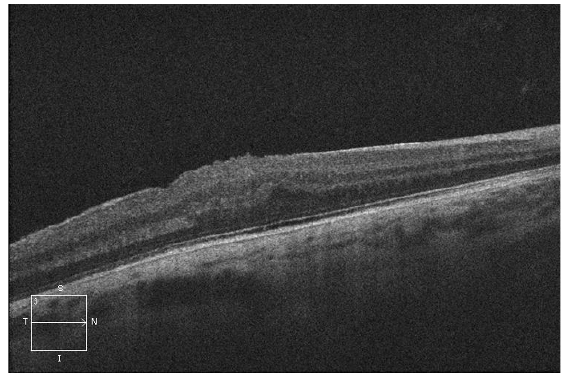
Figure 1. Optical coherence tomography of the epiretinal mem- brane in the right eye.